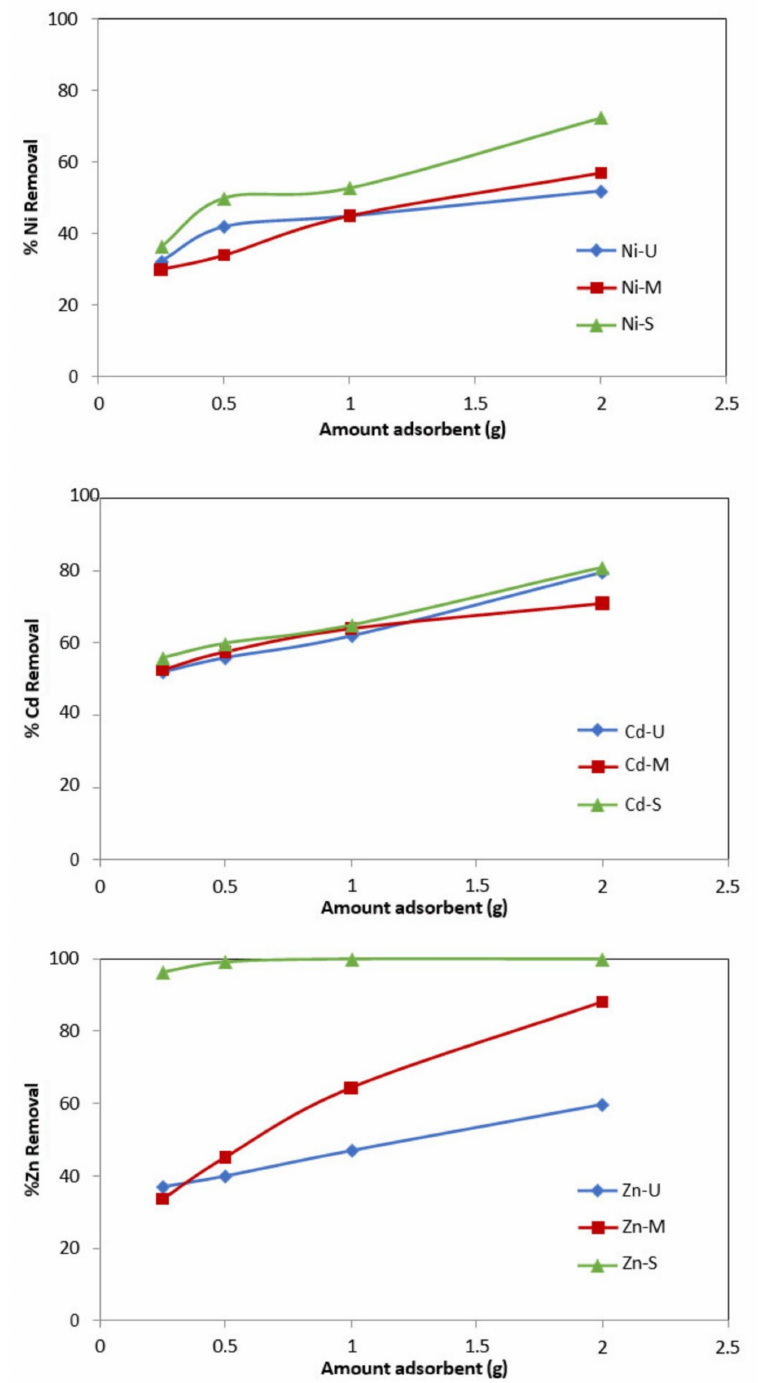
Figure 13. Effect of amount of adsorbent versus % of metal removal. ( Co = 50 mg/L, adsorbent = 0.25–2 g, t = 24